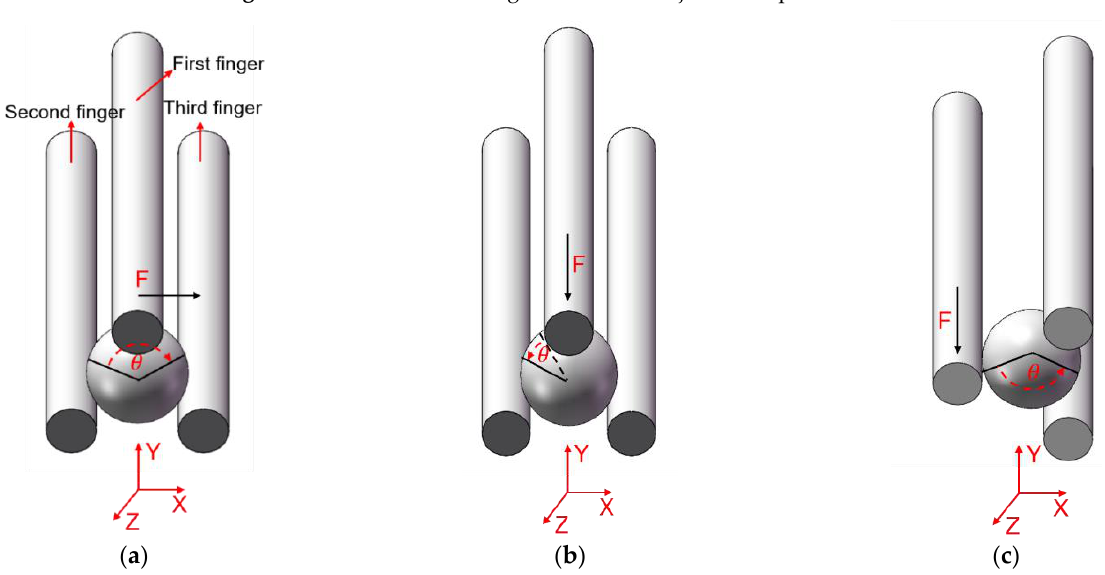
Figure 13. Rotations of micro an object with the microgripper: ( a ) Rotation about axis Z, ( b ) Rotation about axis X, and ( c ) Rotation about axis Y.